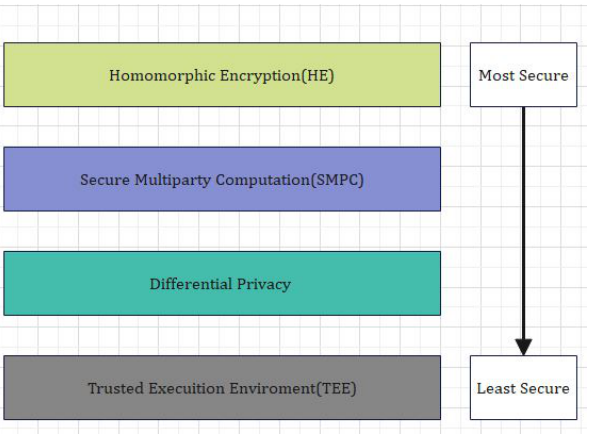
Figure 2. Comparative Analysis of different Privacy and Security